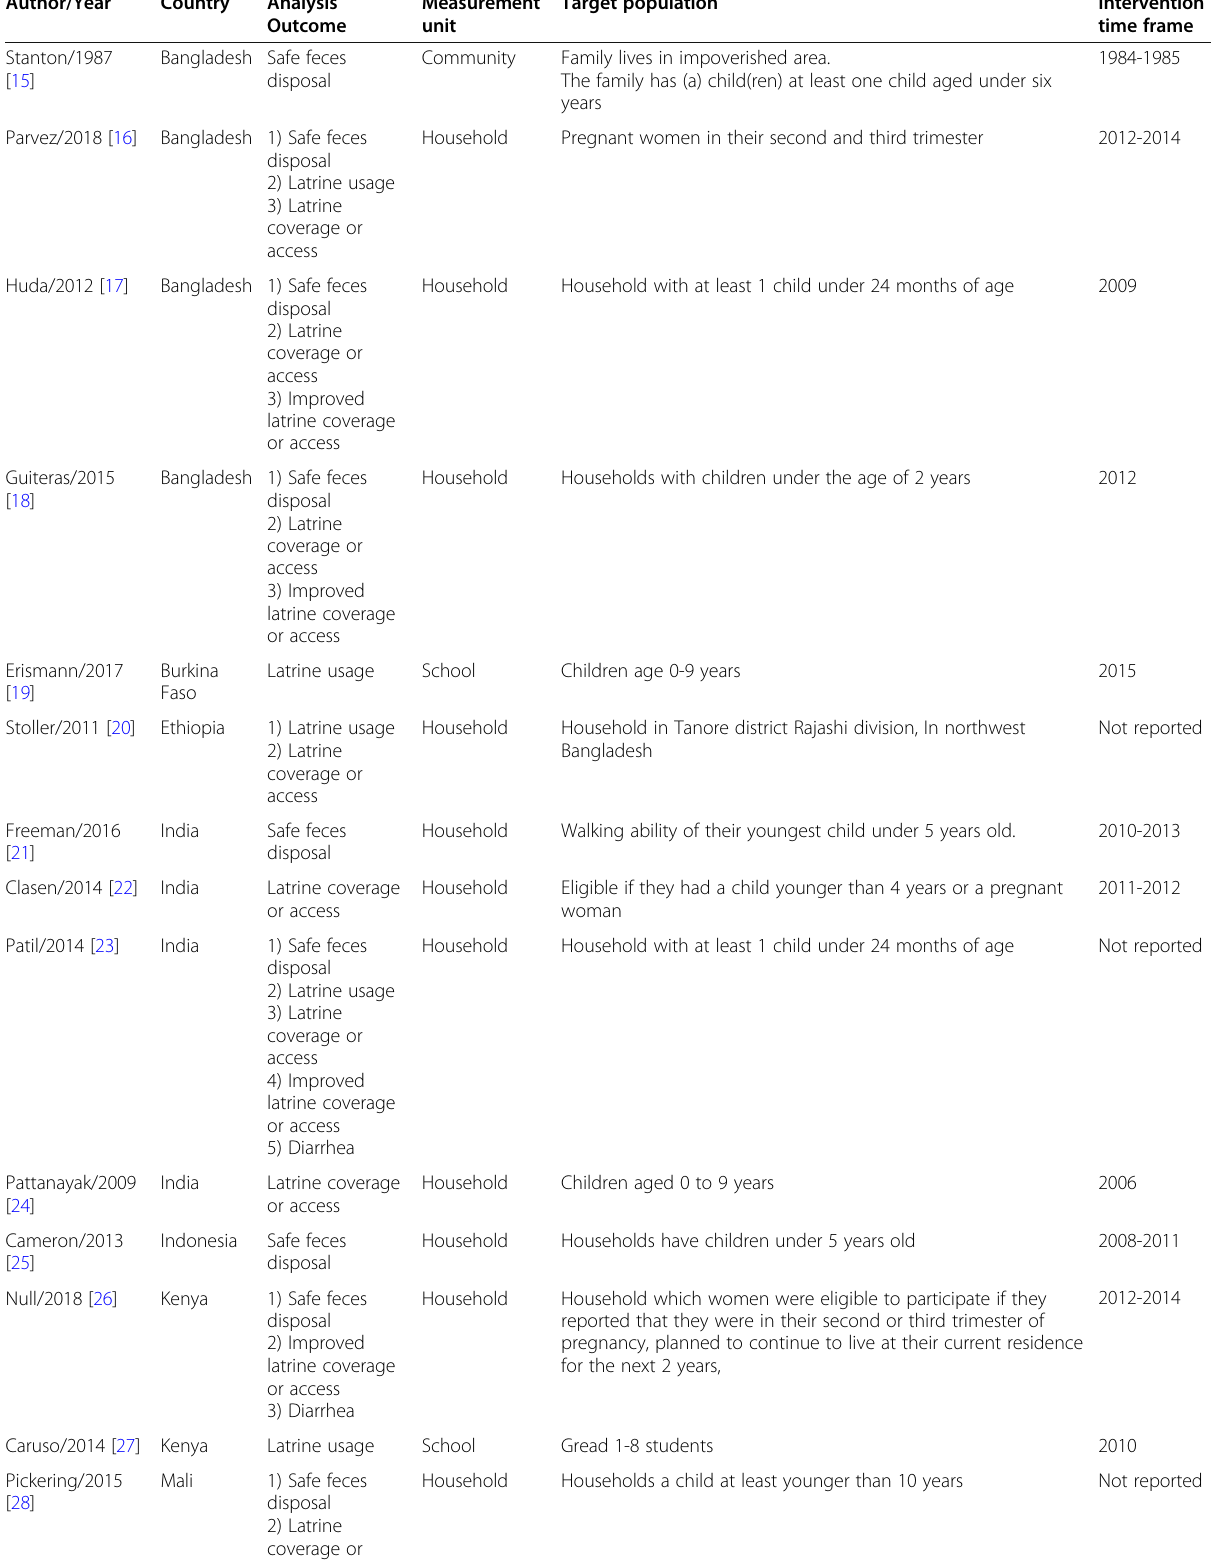
Table 1 Characteristic of included in